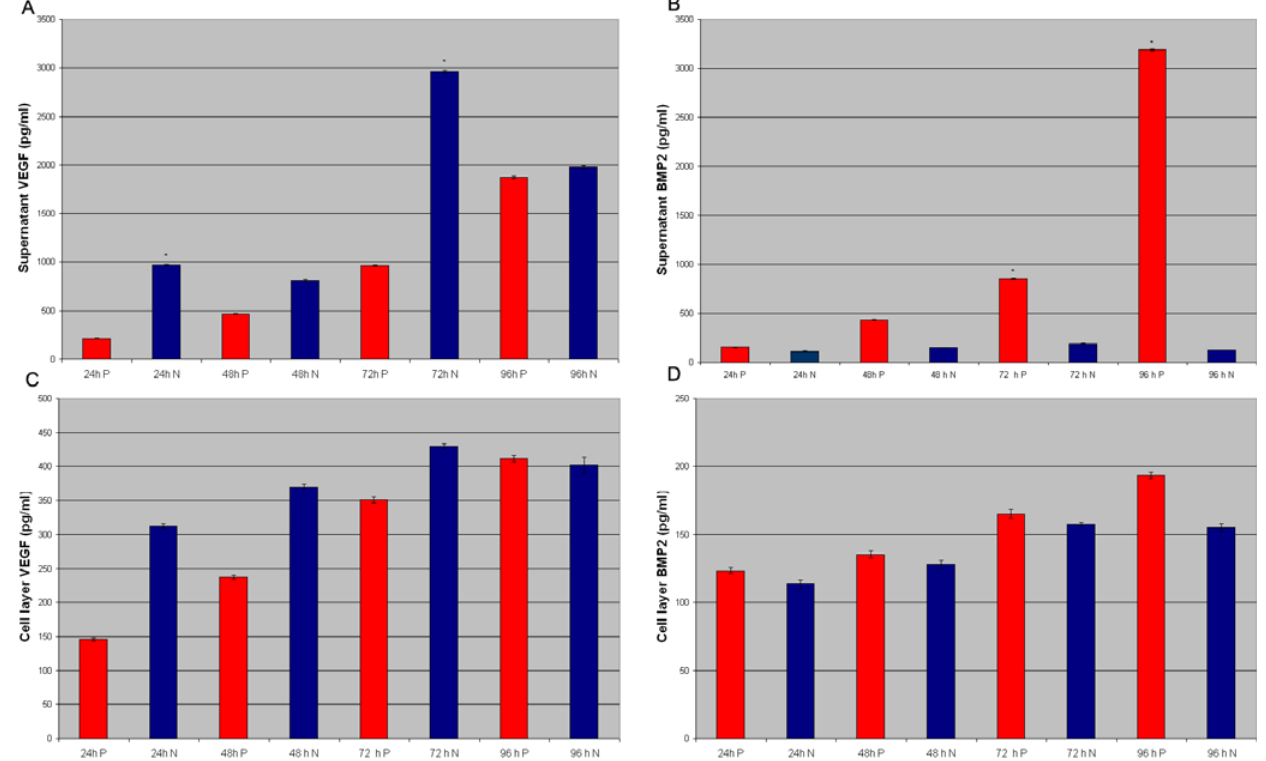
Figure 4. ELISA assays performed on (A) VEGF and (B) BMP2 released within the supernatant by SBP-DPSCs after 24, 48, 72 and 96h from plating on smooth and concave textured surface; ELISA assays performed on (C) VEGF and (D) BMP2 present in the cell layer of SBP-DPSCs after 24, 48, 72 and 96h from plating on smooth and concave texturing. Each experiment was performed in triplicate (n=3). The error bars are 6 SD. *p , 0.01. N indicates samples not NMP-treated; P indicates NMP-treated